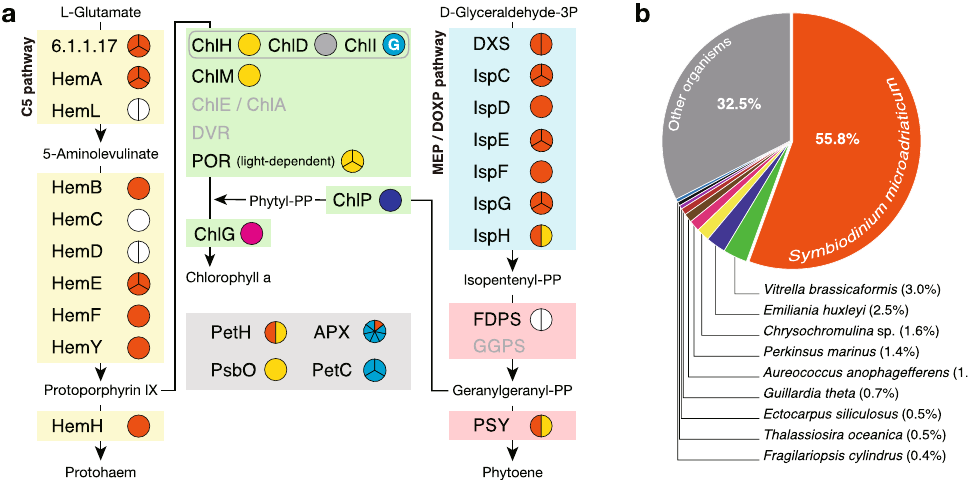
Figure 4. ( a ) The deduced origins of proteins involved in porphyrin, chlorophyll, isoprenoid and carotenoid biosyntheses as well as in photosynthesis, and ( b ) the top 10 species in the Basic Local Alignment Search Tool (BLAST) search are shown. Yellow, green, blue, pink and grey boxes in ( a ) indicate proteins related to the biosynthesis pathways for porphyrins (haem), chlorophylls, isoprenoids and carotenoids, as well as photosynthesis, respectively. Names presented in black and grey indicate identified and unidentified proteins in this study, respectively. Pie charts present identified proteins, and the colours denote proteins originated from peridinin dinoflagellates (orange), fucoxanthin dinoflagellates (yellow), haptophytes (blue), chlorarachniophytes (magenta), cryptophytes (light blue) and cyanobacteria (grey). White pie charts indicate proteins for which the origin is unclear due to a low phylogenetic tree resolution. ‘G’ in the ChlI pie chart indicates that the ChlI gene was coded in the chloroplast genome of T. amphioxeia (accession no. YP_009159192). In ( b ), homologous species in the BLAST search are arranged by relative abundance in descending order in a clockwise